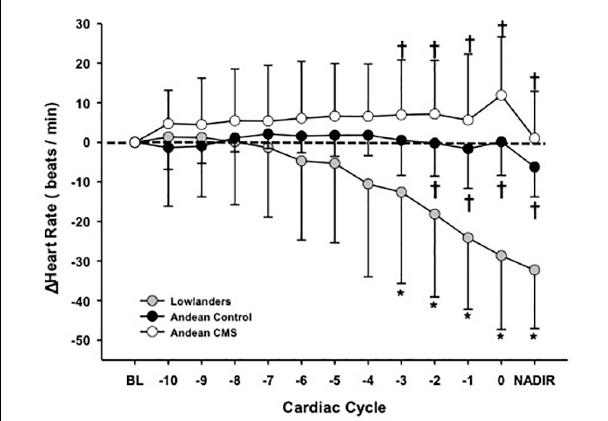
FIGURE 1 | Absolute heart rate response (delta change) during maximal end-inspiratory apnea within Lowlanders (gray circle; N.13), Andean controls (CMS-: black circle; N.9), and Andean CMS patients (CMS +; white circle; N.8). The baseline HR for each group at 4330 m (represented as “0 beats/min”) and nadir response (lowest beats/min obtained during the last 10 cardiac cycles) have also been identified. Lowlanders developed significant bradycardia response prior to volitional breakpoint while both Andean controls and CMS patients had a preserved heart rate response. * Significant difference between cardiac cycle and baseline, P < 0.05. † Significant difference from Lowlanders, P <